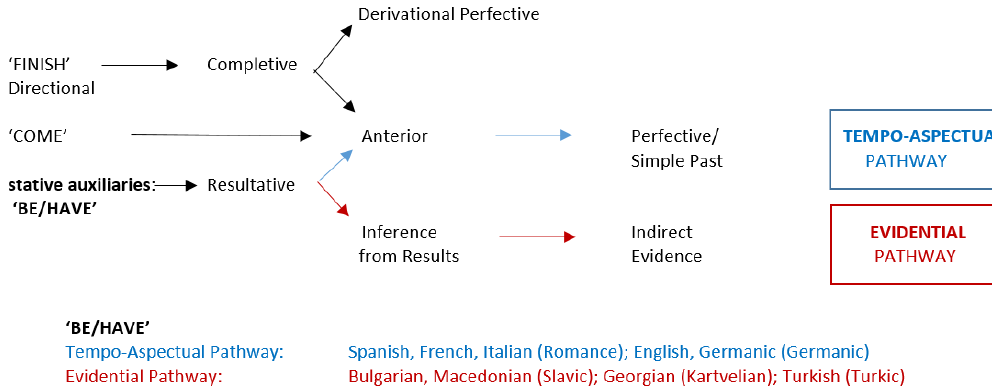
Source: Adapted from Bybee, Perkins & Pagliuca (1994: